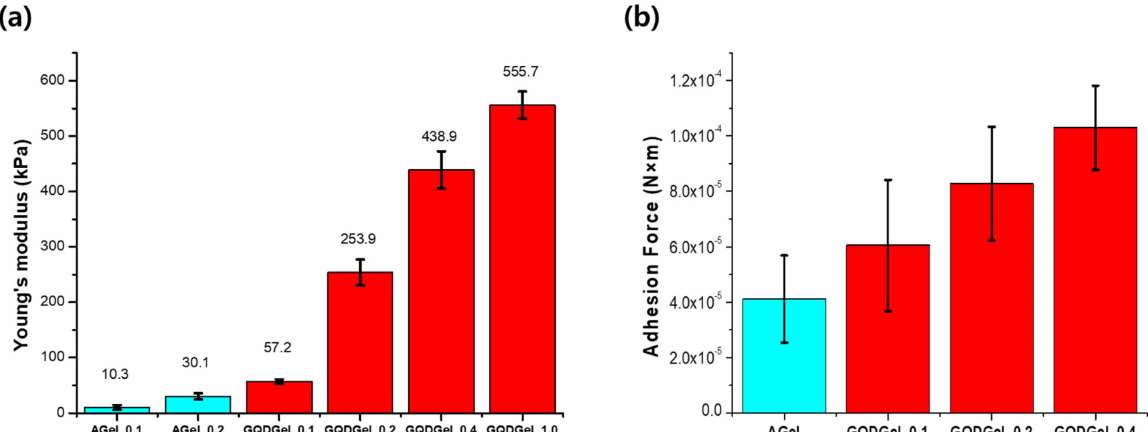
Figure 5. Mechanical characterization of the fabricated hydrogel. ( a ) Calculated Young’s modulus for each sample. ( b ) Surface adhesion force of AGel and GQDGel samples measured by contact mode AFM measurement. The plotted values are the average of 10 µ m × 10 µ m measurement. All experiments were performed in triplicate.